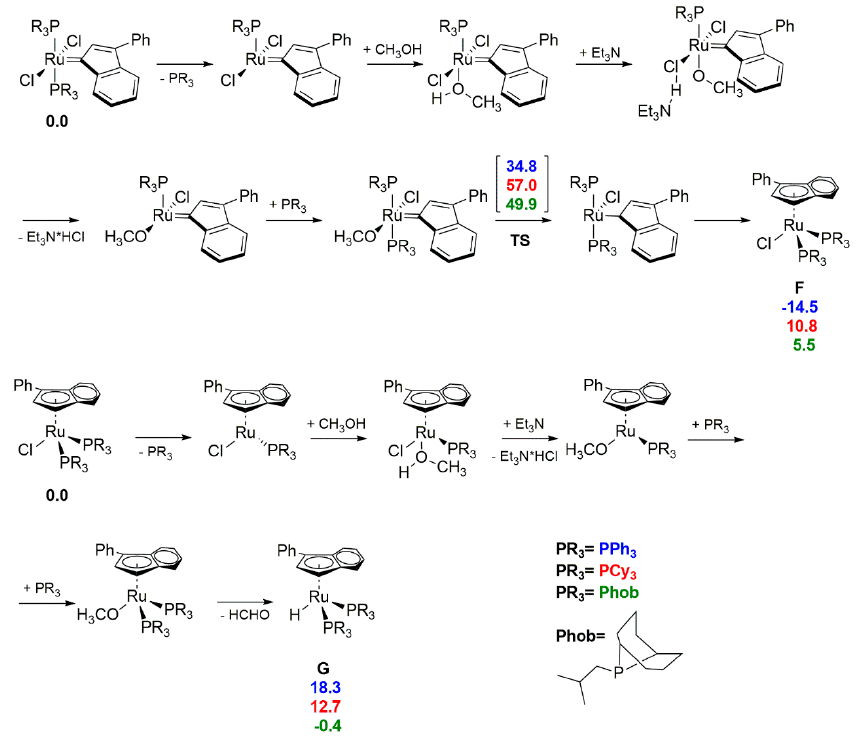
Scheme 16. The energy profile of M11 , M10 , M1 formation from the DFT calculations (values in